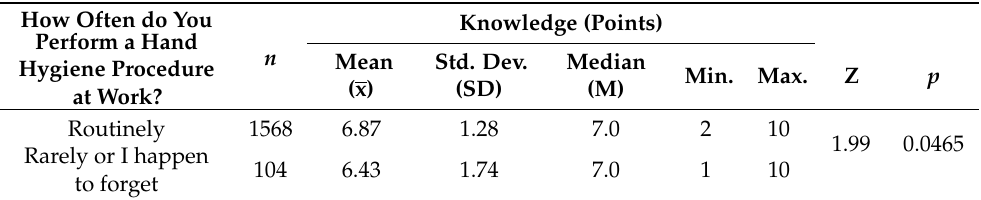
Table 7. Descriptive statistics on the level of knowledge among subjects performing the hand hygiene procedure with different frequency and the Mann–Whitney U test results (Z).